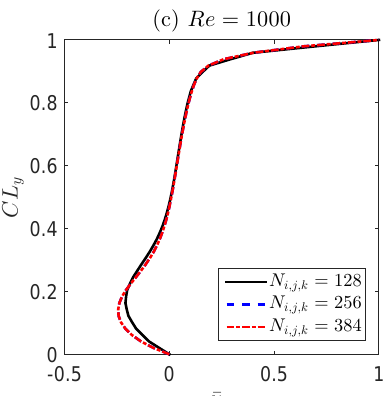
u component along the vertical centreline ( CL y ) of the cavity for three different grid-resolutions at different Reynolds numbers of ( a ) Re = 100; ( b ) Re = 400; and ( c ) Re = 1000.